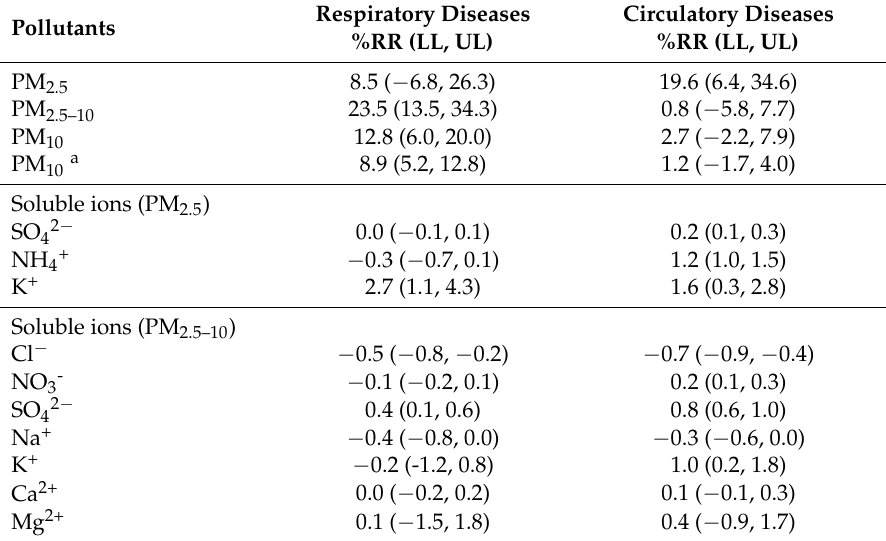
Table 3. Relative Risk percentage (%RR) and confidence interval (95% CI) in polynomial distributed lag model (PDLM) (overall effect within 0–5 days) to elderly hospital admissions for respiratory and circulatory